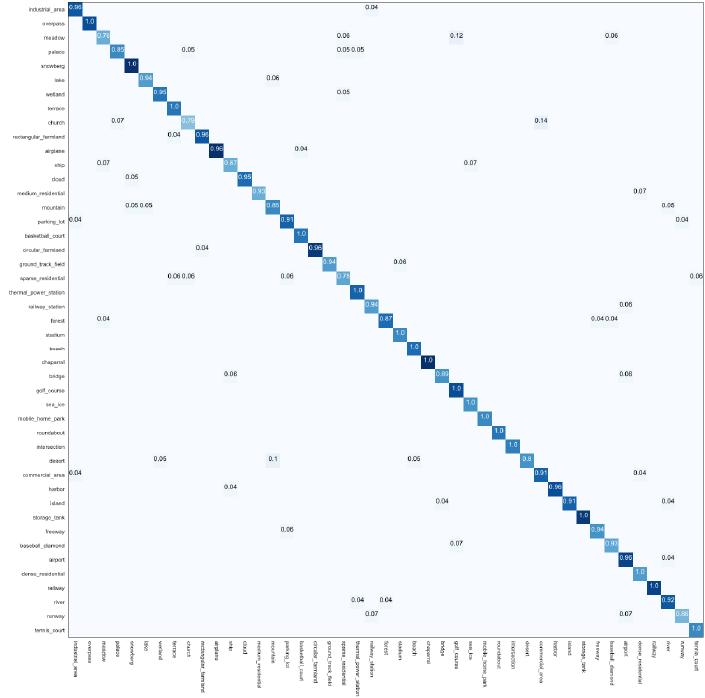
Figure 7. Confusion matrices of the NWPU-RESISC45 dataset under the training ratio of 80% using DDRL-AM. The results in Figure 7 correspond to results shown in Table 3.